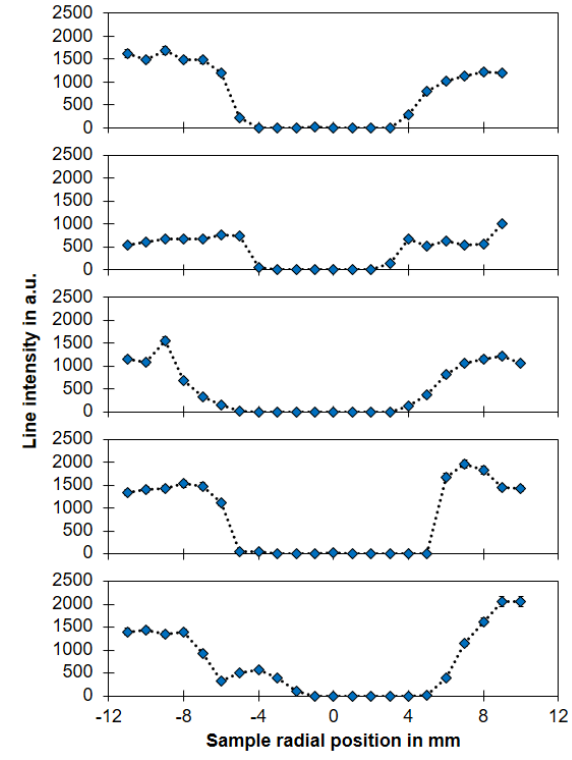
Fig. 1. Intensity of the Al I 396.15 nm transition vs. sample radial position of different commercial fused silica plates